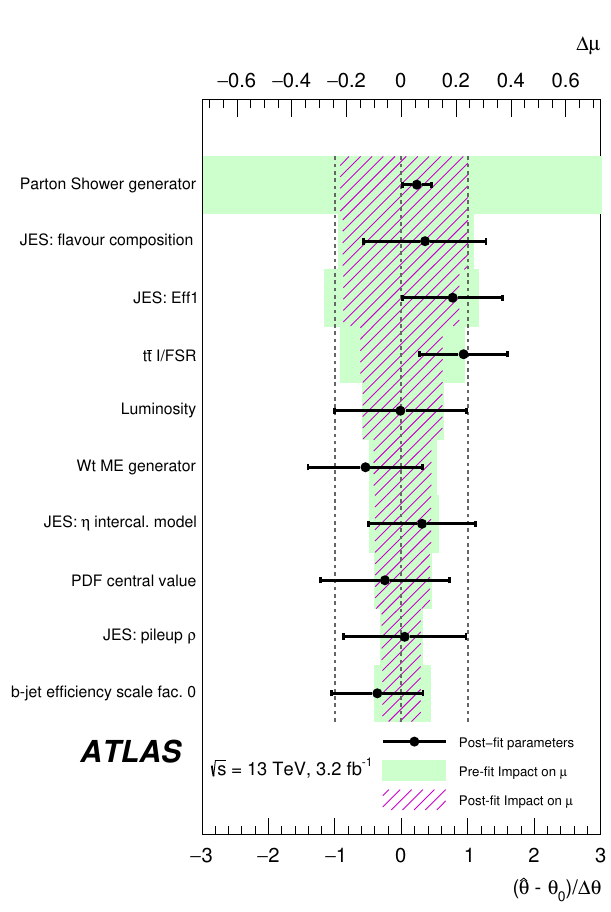
List of (cid:12)t parameters ranked by post-(cid:12)t impact on the signal strength. The (cid:12)t parameters ( (cid:18) ) here correspond to the nuisance parameters from section 8. Impact ((cid:1) (cid:22) ) is calculated by (cid:12)xing the parameter to its (cid:6) 1 (cid:27) values, (cid:12)xing all other parameters to their nominal values, re-(cid:12)tting the signal strength, and evaluating the change in signal strength with respect to the nominal (cid:12)t. Green bands indicate the impacts computed with (cid:27) corresponding to the pre-(cid:12)t uncertainty, and hatched purple bands indicate the impacts computed with (cid:27) corresponding to the post-(cid:12)t uncertainty. The black points represent (^ (cid:18) (cid:0) (cid:18) 0 ) = (cid:1) (cid:18) , the shifted and scaled post-(cid:12)t parameter values, while the error bars are the post-(cid:12)t errors of the (cid:12)t parameter. The meanings of the labels and abbreviations are detailed in section